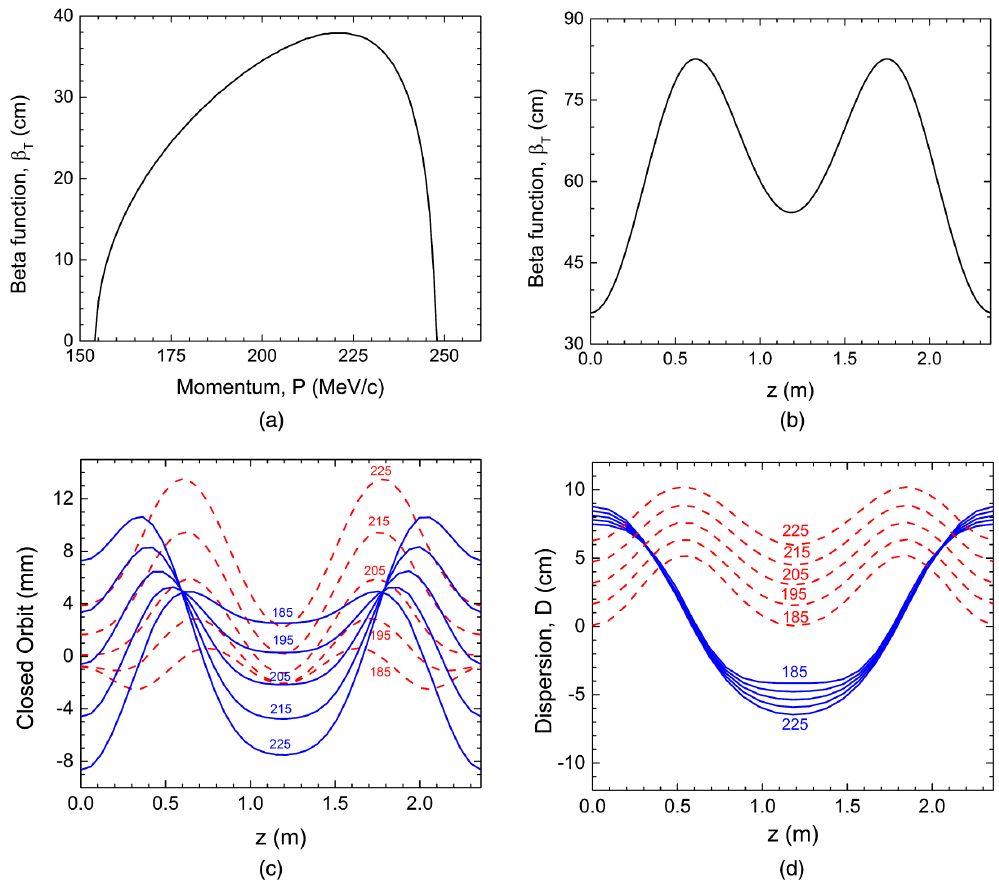
FIG. 3. Lattice properties for stage 2. (a) Beta function at the absorber center vs momentum; (b) beta function vs position at the reference momentum of 205 Mev =c ; (c) deviations from the central line of the channel in the horizontal direction (red) and in the vertical direction (blue). The different lines correspond to orbits of different momentum muons; (d) dispersion vs position for different momentum